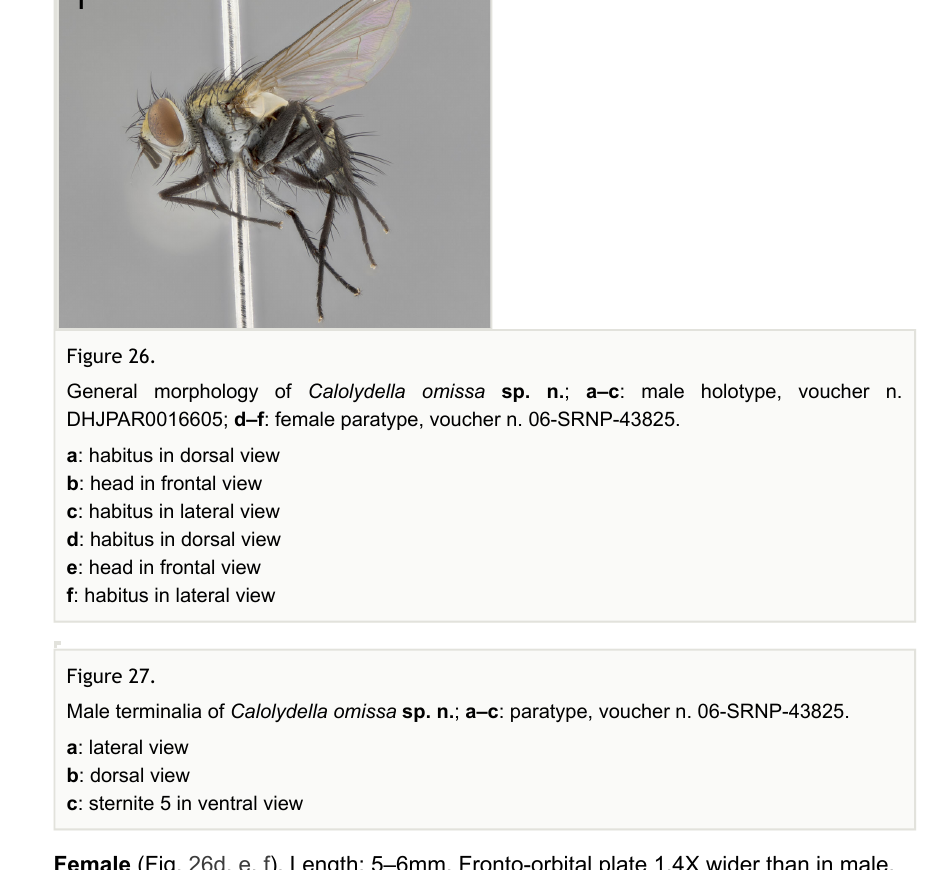
Female (Fig. 26d, e, f). Length: 5–6mm. Fronto-orbital plate 1.4X wider than in male. Diagnosis Calolydella omissa can be distinguished from all other species of Calolydella by the following combination of traits: fronto-orbital plate gold, parafacial silver, abdomen with uninterrupted transverse silver pollinose bands across all tergites, anatergite bare (rarely setose), and T3 without discal setae.